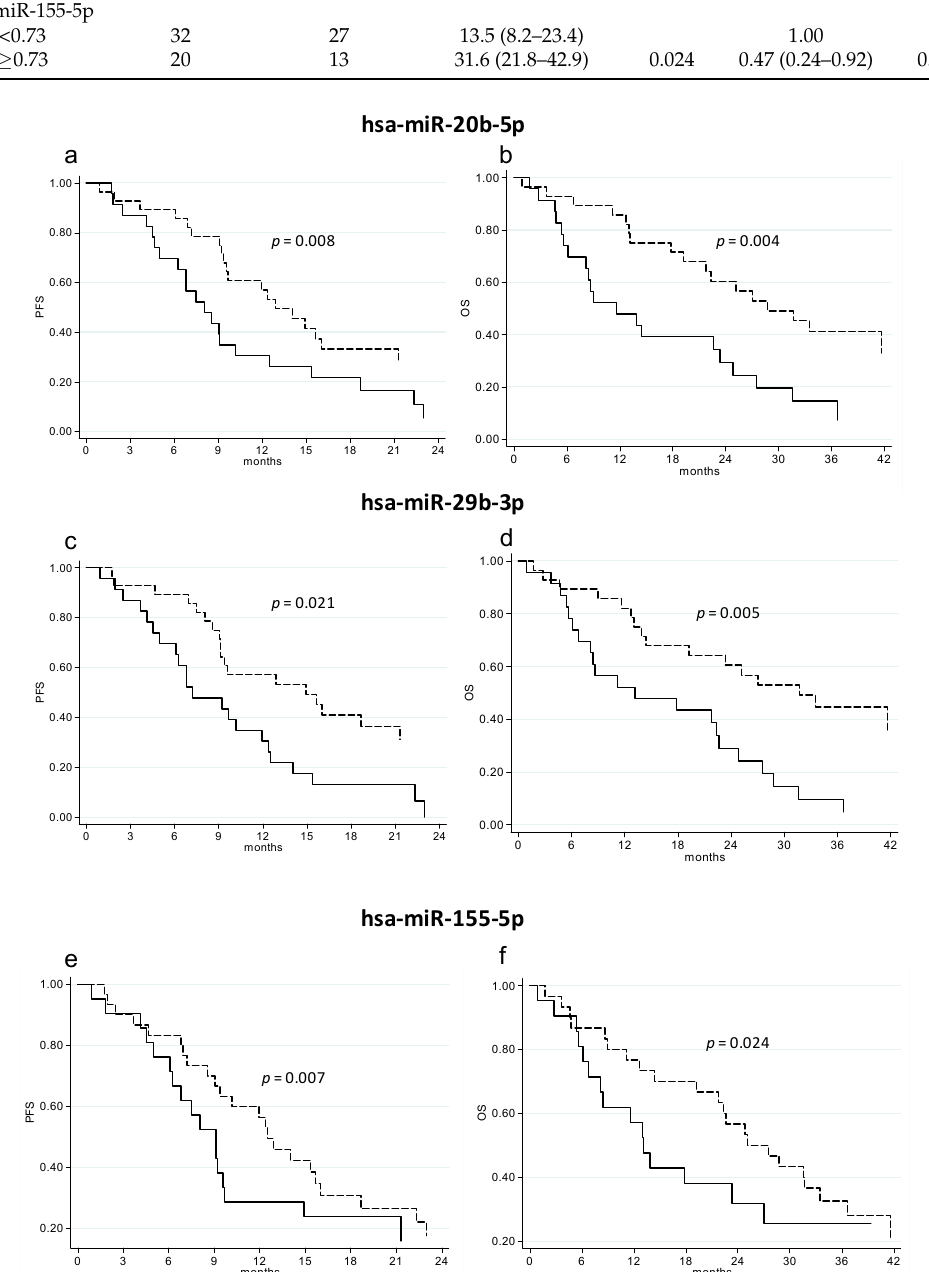
Figure 1. PFS and OS of basal circulating levels of hsa-miR-20b-5p ( a , b ), hsa-miR-29b-5p ( c , d ) and hsa-miR-155-5p ( e , f ). Dashed lines represent patients with miRNA values greater than the median value, whereas continuous lines represent patients with miRNA values lower than the median value.